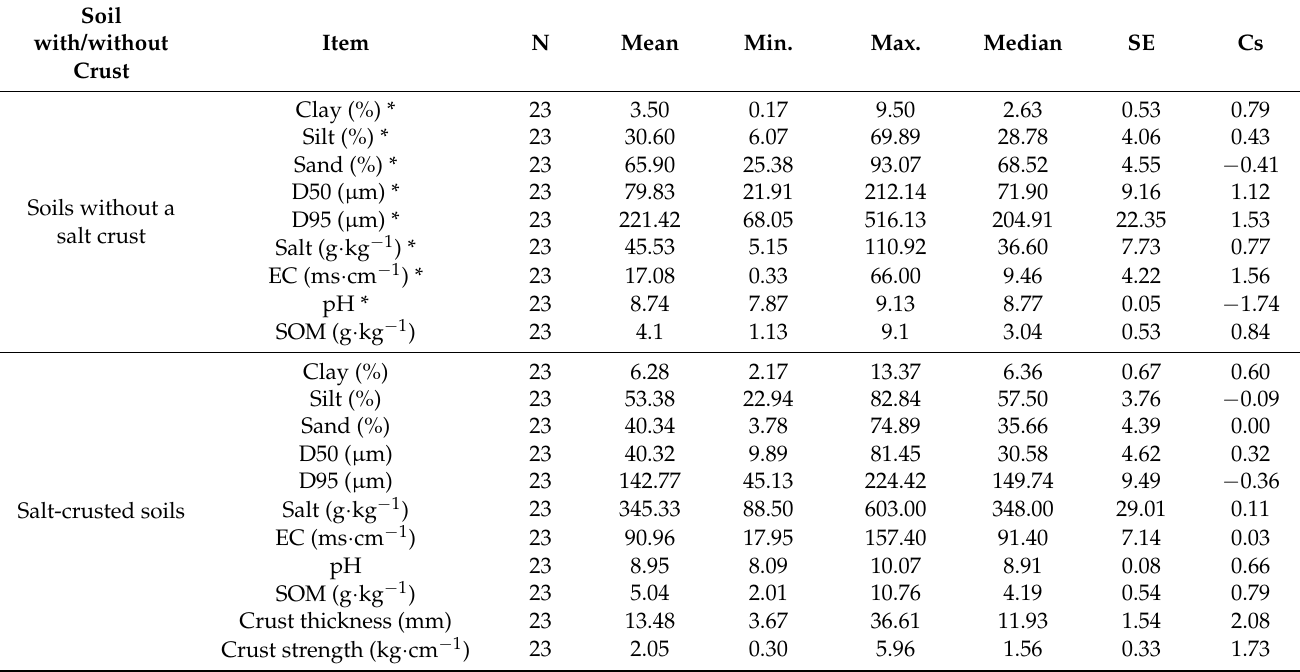
Table 1. Summary statistics of soil properties.